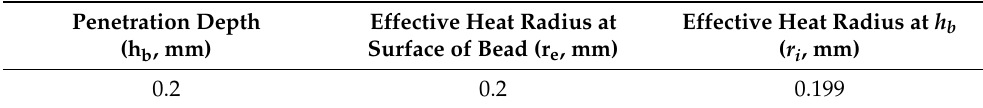
Figure 7. Volumetric top-hat distribution of heat flux with penetration depth model on a deposited bead. Table 3. Parameters for finite element model during the deposition process.